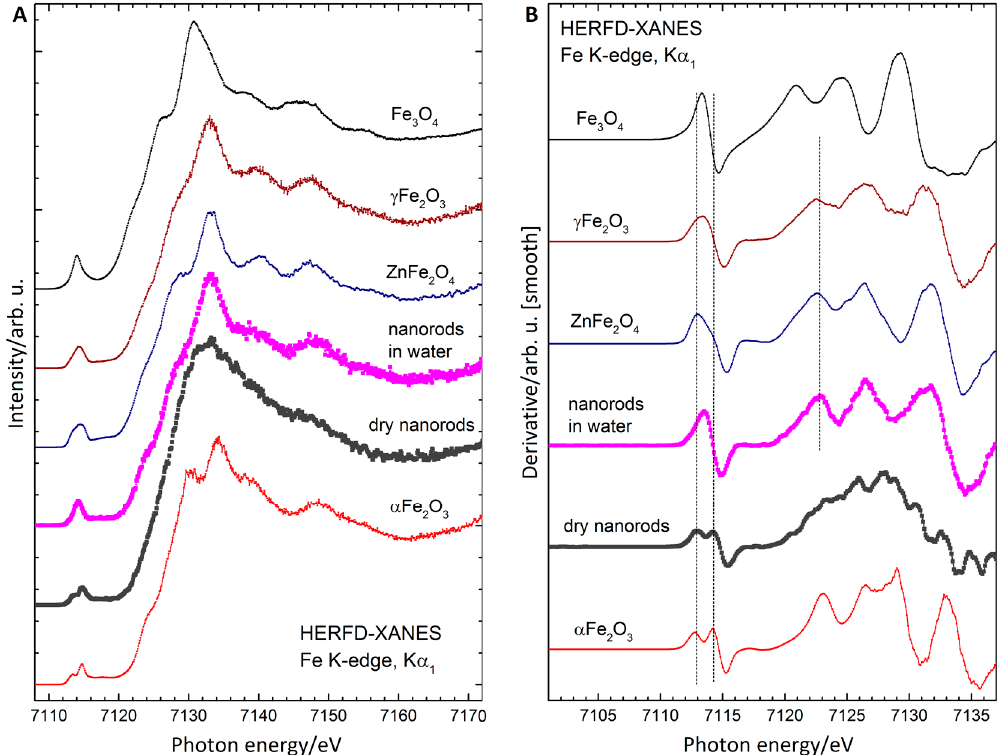
Figure 6. Fe K-edge HERFD-XANES spectra of zinc ferrite nanorods compared to reference spectra of selected iron oxides ( A ) and first derivative of the smoothed HERFD-XANES ( B ).